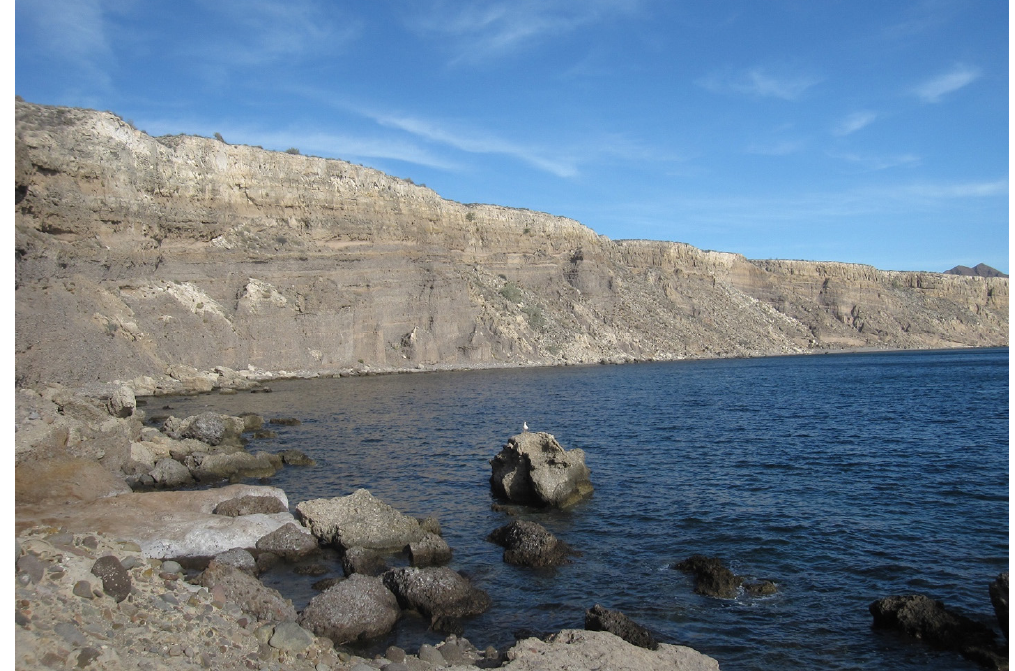
Figure 6. Oblique view of the arch-shaped PlioceneTiombó conglomerate in cross-section, stretching south to north over a distance of 2 km on the east coast of Isla del Carmen. Another Pliocene deposit, also linked with outwash dynamics dependent on storm- related rainfall, occurs far to the north of Isla del Carmen (Figure 4), where the 50-m thick Ballena fan delta covers a map area of 4 km 2 with sandstone layers dipping nearly 3° sea- ward in an arcuate pattern [51]. Equally far to the south of Isla del Carmen, yet another Pliocene deposit, with carbonate sands framed above and below by thick boulder depos- its, occurs at Paredones Blancos on Isla Cerravo (Figure 4) [52]. In this case, coarse outwash deposits stripped from the interior of a large island are interrupted by an interval of sub- sidence and relative rise in sea level that filled a 0.5-km wide embayment. Upper Pleistocene deposits, correlated with Marine Isotope Substage 5e during the last interglacial episode roughly 125,000 years ago, also are well represented in the Gulf of California (Table 2), although not nearly at the same scale as older Pliocene storm de- posits. Rhodolith sand deposited in a paleolagoon on Isla Coronados (Figure 7) are inter- preted as repetitive overwash events during major storms arriving from the south that topped a barrier formed by solid andesite basement rocks [55].